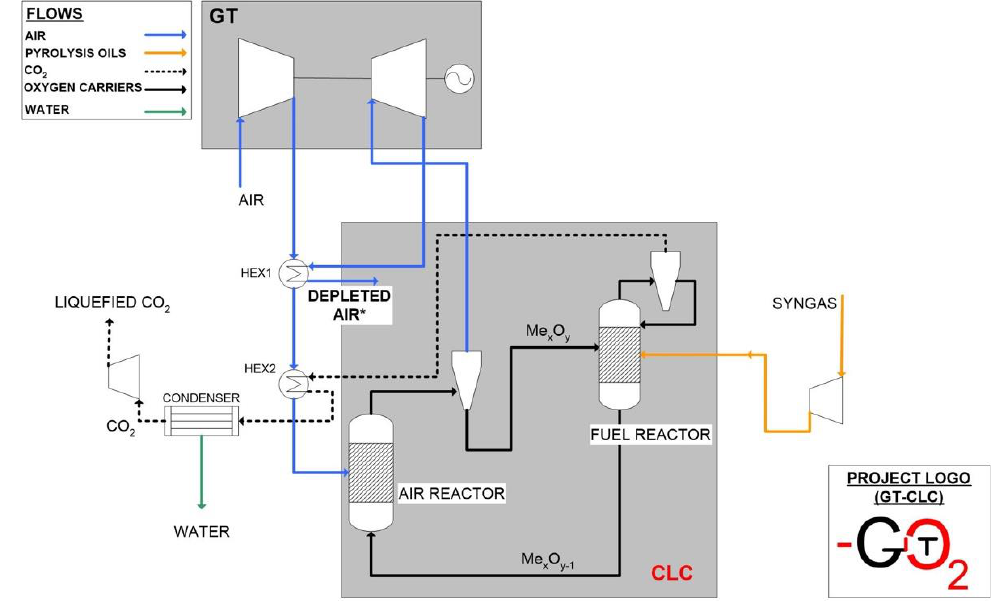
Figure 1. The GTCLC-NEG concept [11].